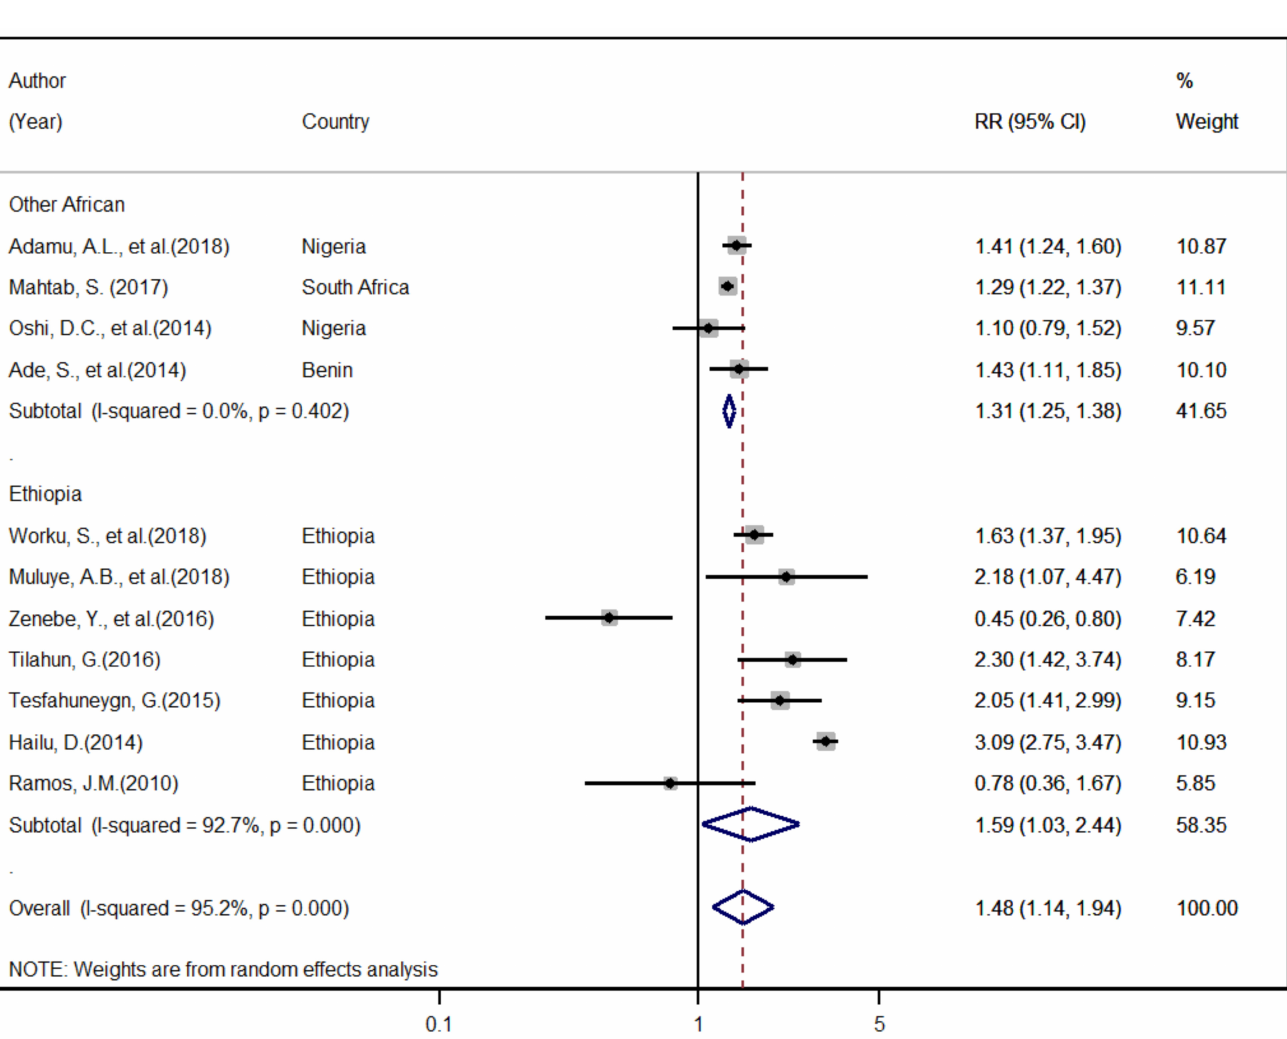
Figure 4. The overall and region-based relative risk of unsuccessful TB treatment outcome that can be associated with